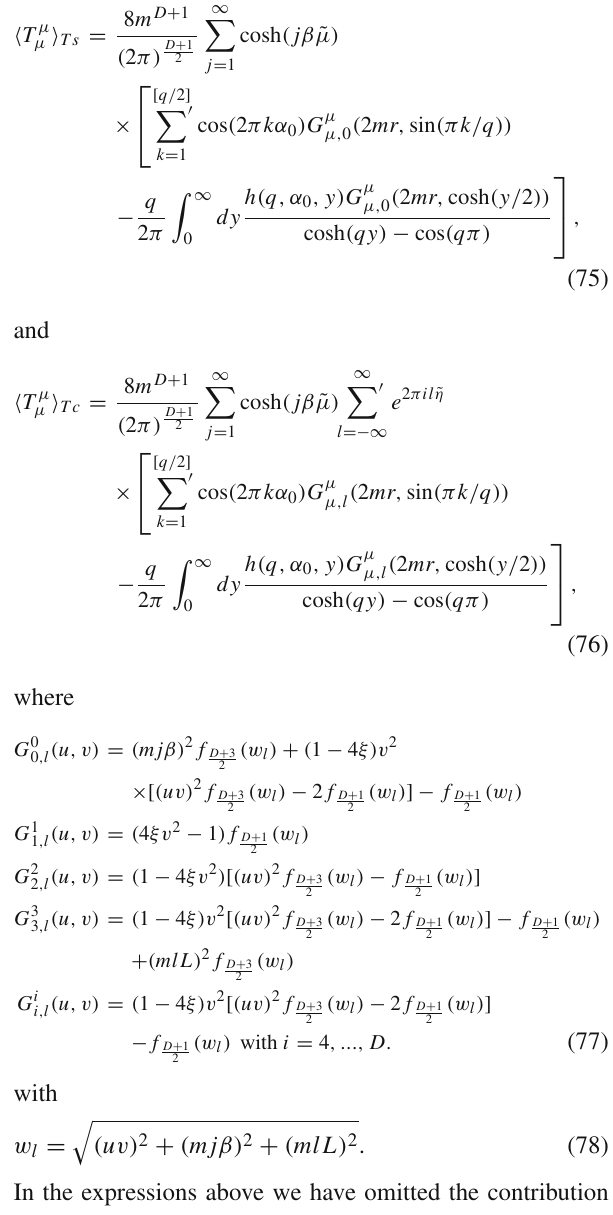
(cid:3) = 3, considering the In Fig.3 we plot the (cid:2) T 0 Ts for D 0 fixed parameters q = 3 . 5, | ˜ μ | / m = 0 . 5 and ξ = 0 (minimal coupling) as a function of the product mr , with different values of the ratio T / m and α 0 . The left panel is plotted for = 0 . 2 and the right panel for α = 0 . 4. The numbers near α 0 0 the curves correspond to values of T / m . In correspondence to the asymptotic analysis made above, the curves with α 0 = 0 . 2 satisfy the constraint relation q | α 0 | < 1 and therefore diverge on the string’s core, r = 0, while the curves for = 0 . 4 obey the constraint q | α | > 1 and are finite on the α 0 0